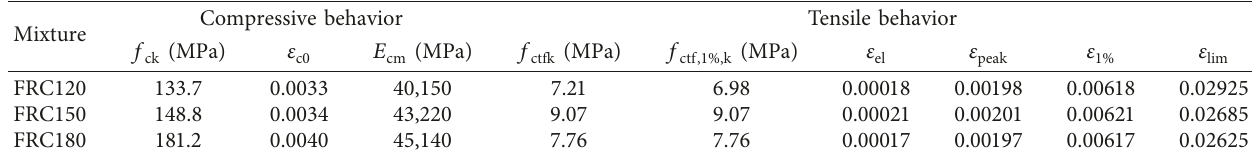
Table 2: Material modeling of the